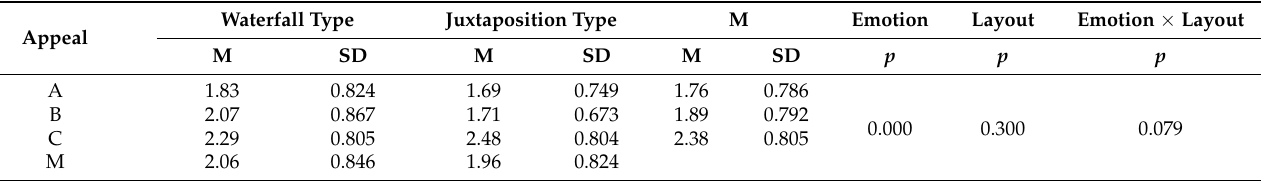
Table 6. Descriptive statistics and two-way ANOVA for the appeal of the